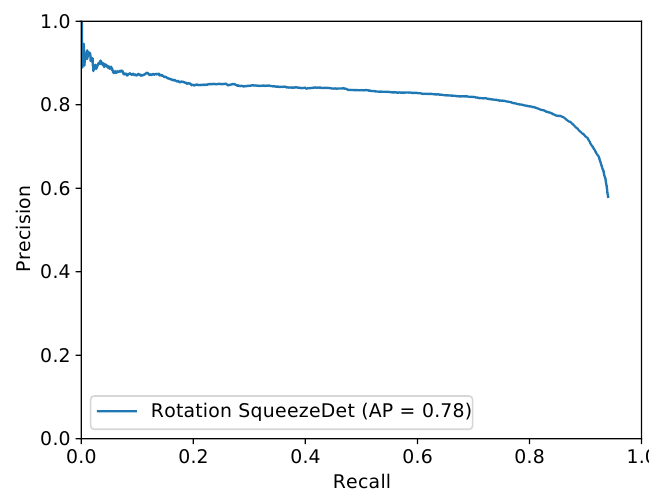
Figure 8. Average Precision (AP) results of Rotation-SqueezeNet validated in UAV-BD.